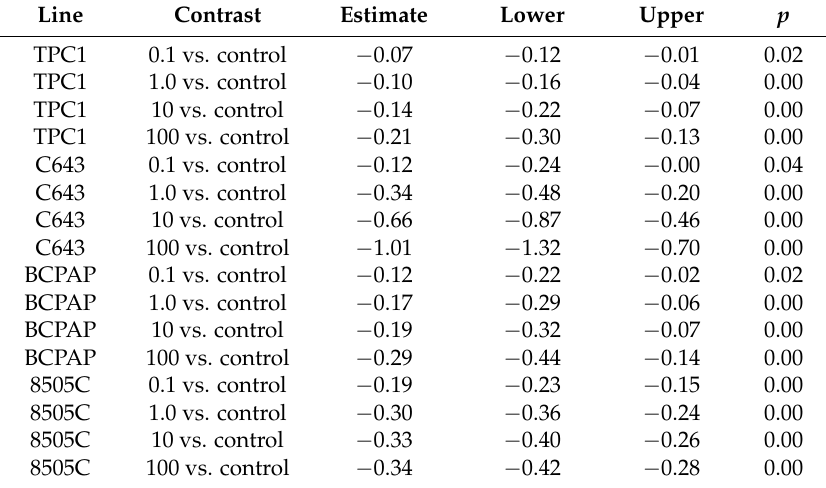
Table 1. p -Values showing that selumetinib treatment was significant at all concentrations for all four cells lines even for the lowest used concentration. p < 0.05 regarded as